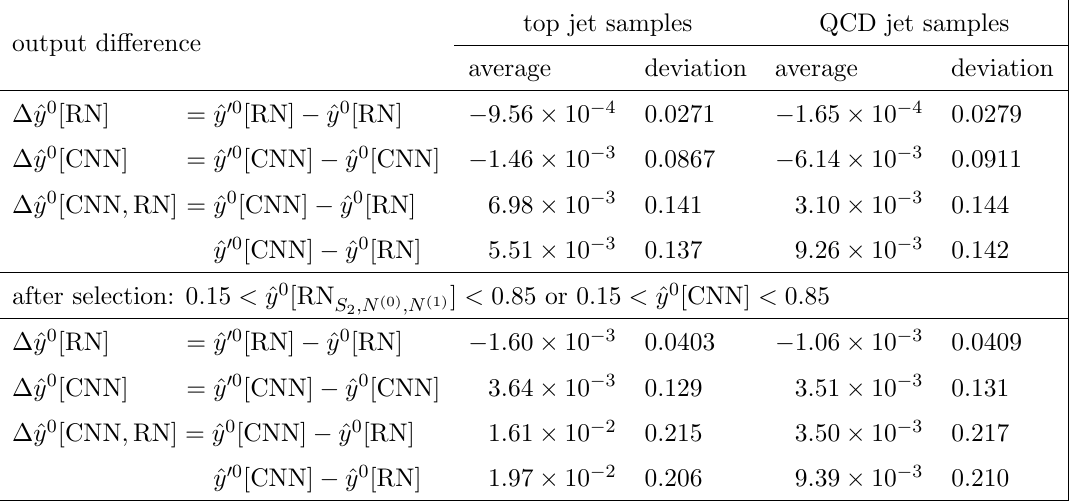
Table 2. Average and standard deviation of the output di(cid:11)erence (cid:1) y 0 .